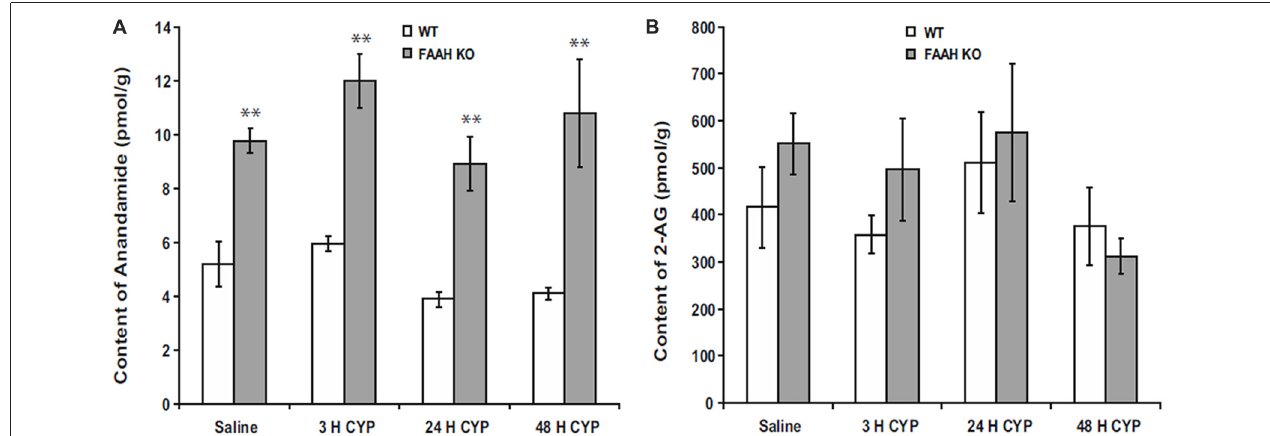
FIGURE 1 | Bladder content of anandamide (AEA) (A) were consistently greater in fatty acid amide hydrolase (FAAH) knock out (KO) mice than wild-type (WT) mice treated with saline (controls) or cyclophosphamide (CYP; 150 mg/kg) given intraperitoneally 3 h prior to sacrifice. Bladder content of 2-arachidonoylglycerol (2-AG; B ) was similar in both KO and WT and was unaffected by treatment. Mean ± SEM. ∗∗ p < 0.01 KO vs. WT; n = 4 for each group. Reprinted by permission from the publisher of Journal of Molecular Neuroscience, Nature/Springer/Palgrave; (Wang et al., 2015b).